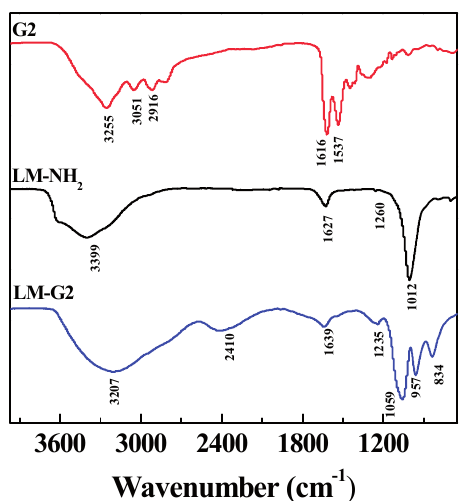
Figure 3. Fourier transform infrared (FTIR) spectra of generation 2 (G2), LM-NH 2 , and